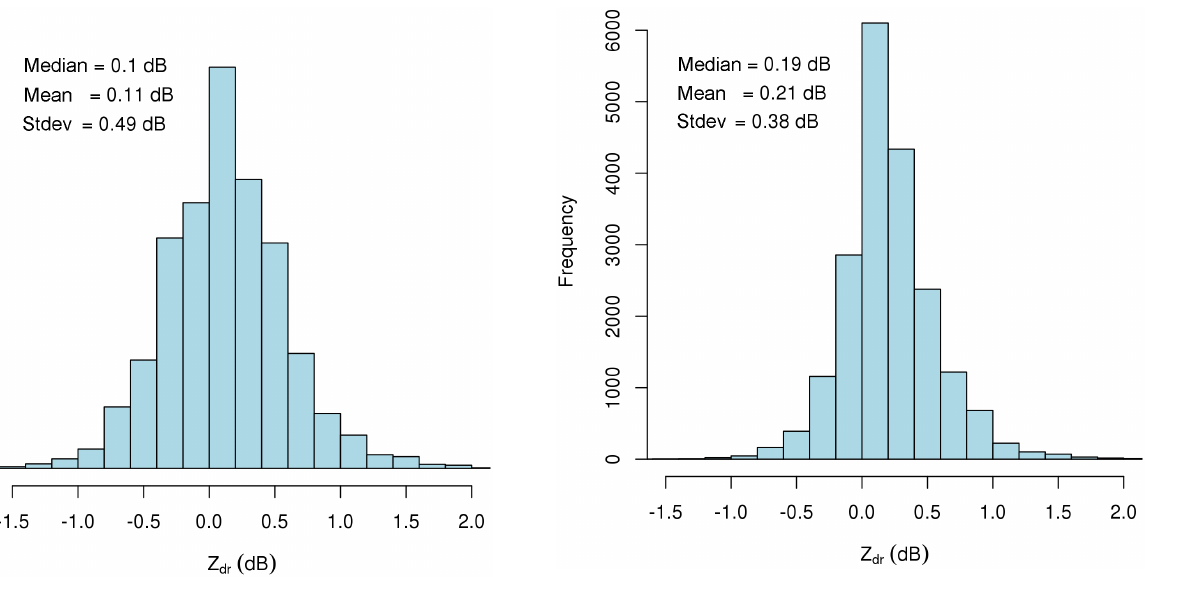
Figure 4. Histogram of differential reflectivity echoes satisfying the selection criteria discussed in Sect. 3.1. Bric della Croce radar, 13 October 2014.